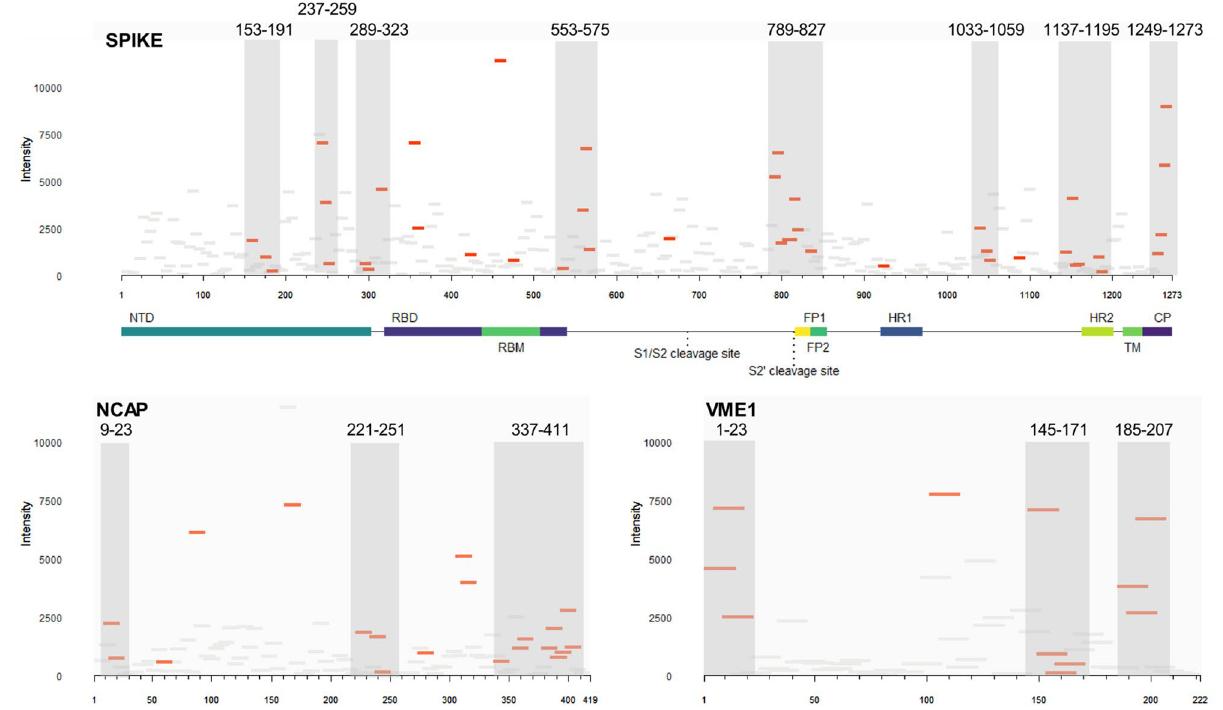
Figure 3. Epitope mapping of SARS-CoV-2 spike, nucleoprotein, and membrane protein reveal distinct clusters of antibody reactivity. Differentially reactive peptides (adjusted p < 0.1, red tiles; adjusted p > 0.1, grey tiles) mapped on to their respective linear sequence. The x-axis of each panel represents the linear protein sequence arranged N-terminus (left) to C-terminus (right); y-axis represents the mean signal intensity for the COVID-19 convalescent sera (n = 22). Grey boxes demarcate epitope clusters, the sequence position is displayed for each. NCAP nucleoprotein, VME1 membrane protein, NTD N-terminal domain, RBD receptor-binding domain, RBM receptor-binding motif, FP fusion peptide, HR heptad repeat, TM transmembrane domain, CP cytoplasmic